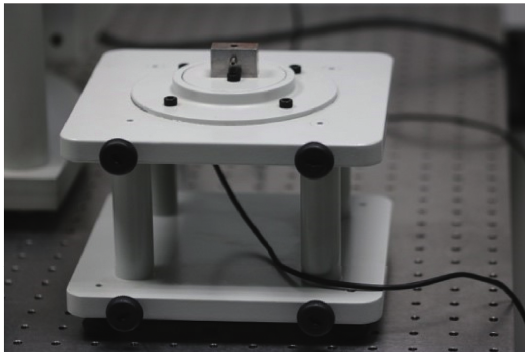
Figure 3: CS-Dental Testing Machine ® load